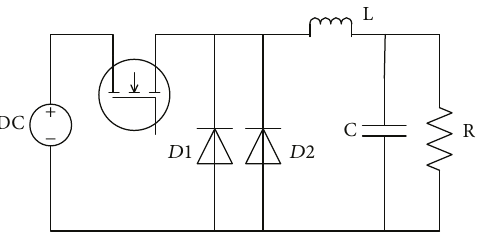
Figure 8: The schematic of experimental